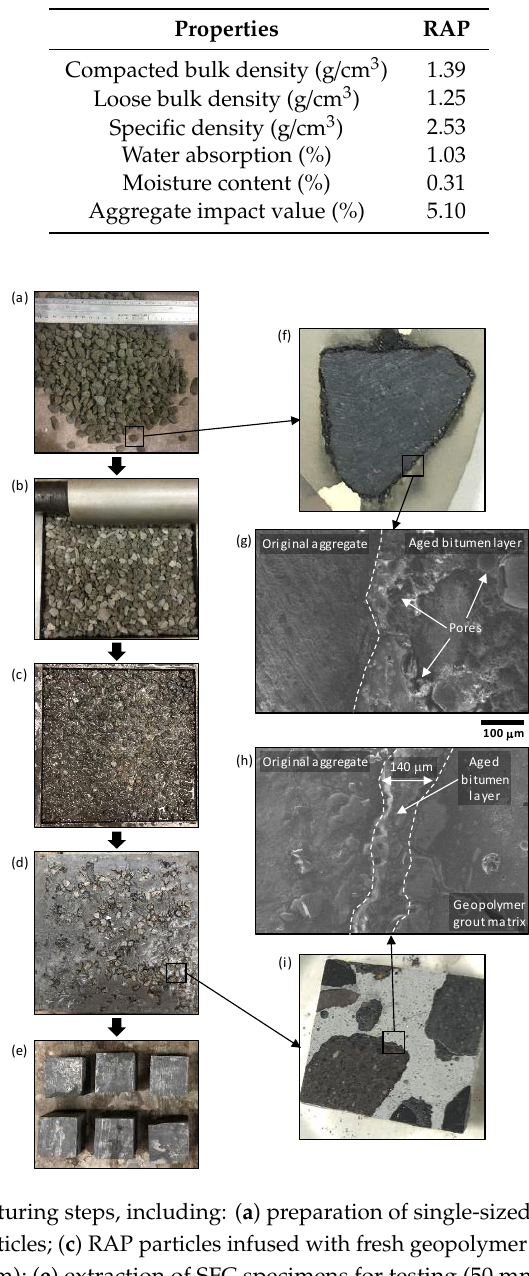
Figure 1. SFC manufacturing steps, including: ( a ) preparation of single-sized RAP particles; ( b ) hand compaction of RAP particles; ( c ) RAP particles infused with fresh geopolymer grout; ( d ) hardened SFC slab (200 × 200 × 50 mm); ( e ) extraction of SFC specimens for testing (50 mm cubes for compressive strength testing shown); ( f , g ) SEM characterisation of RAP particle; and ( h , i ) SFC specimen.